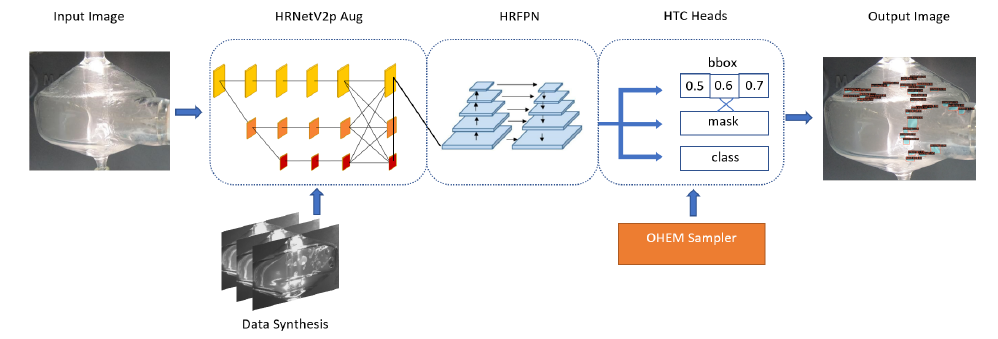
Figure 5. The beading detection pipeline with each component